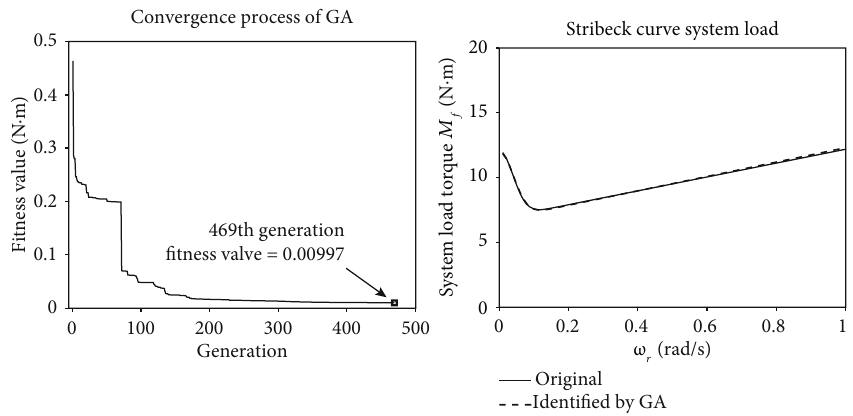
Figure 12: Parameter identi fi cation result of the system load model using the genetic